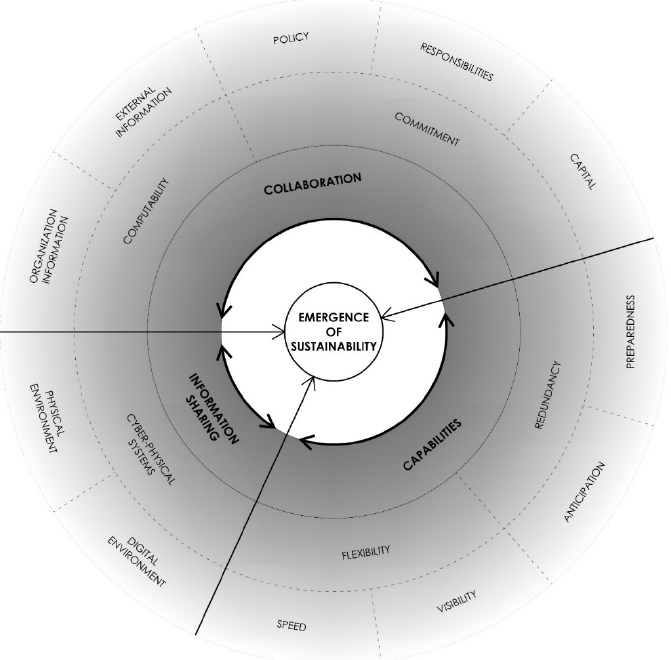
Figure 1. Operationalization of key characteristics for the implementation of the framework, created by authors.